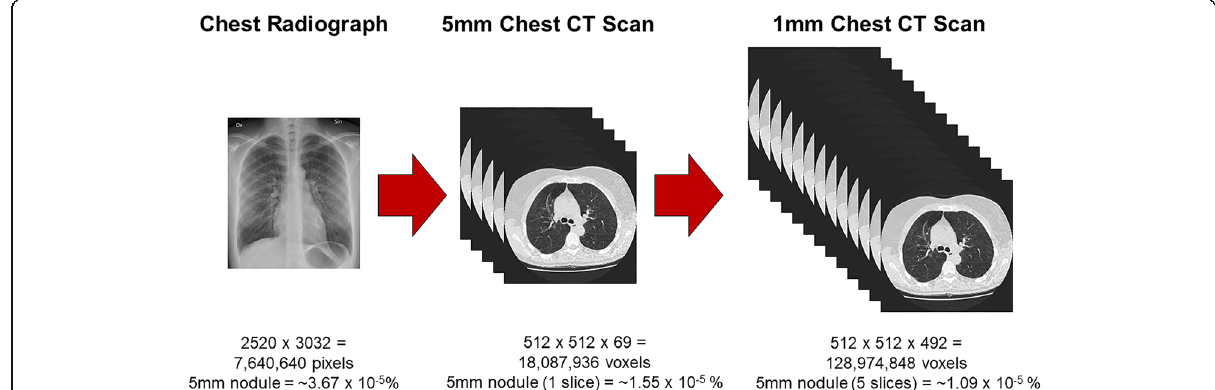
Fig. 1 Size comparison of two-dimensional medical images and volumetric medical images. Image sizes are estimates and actual image sizes may vary considerably between cases. Lung nodule size estimates assume a 96-dpi monitor. CT, computed